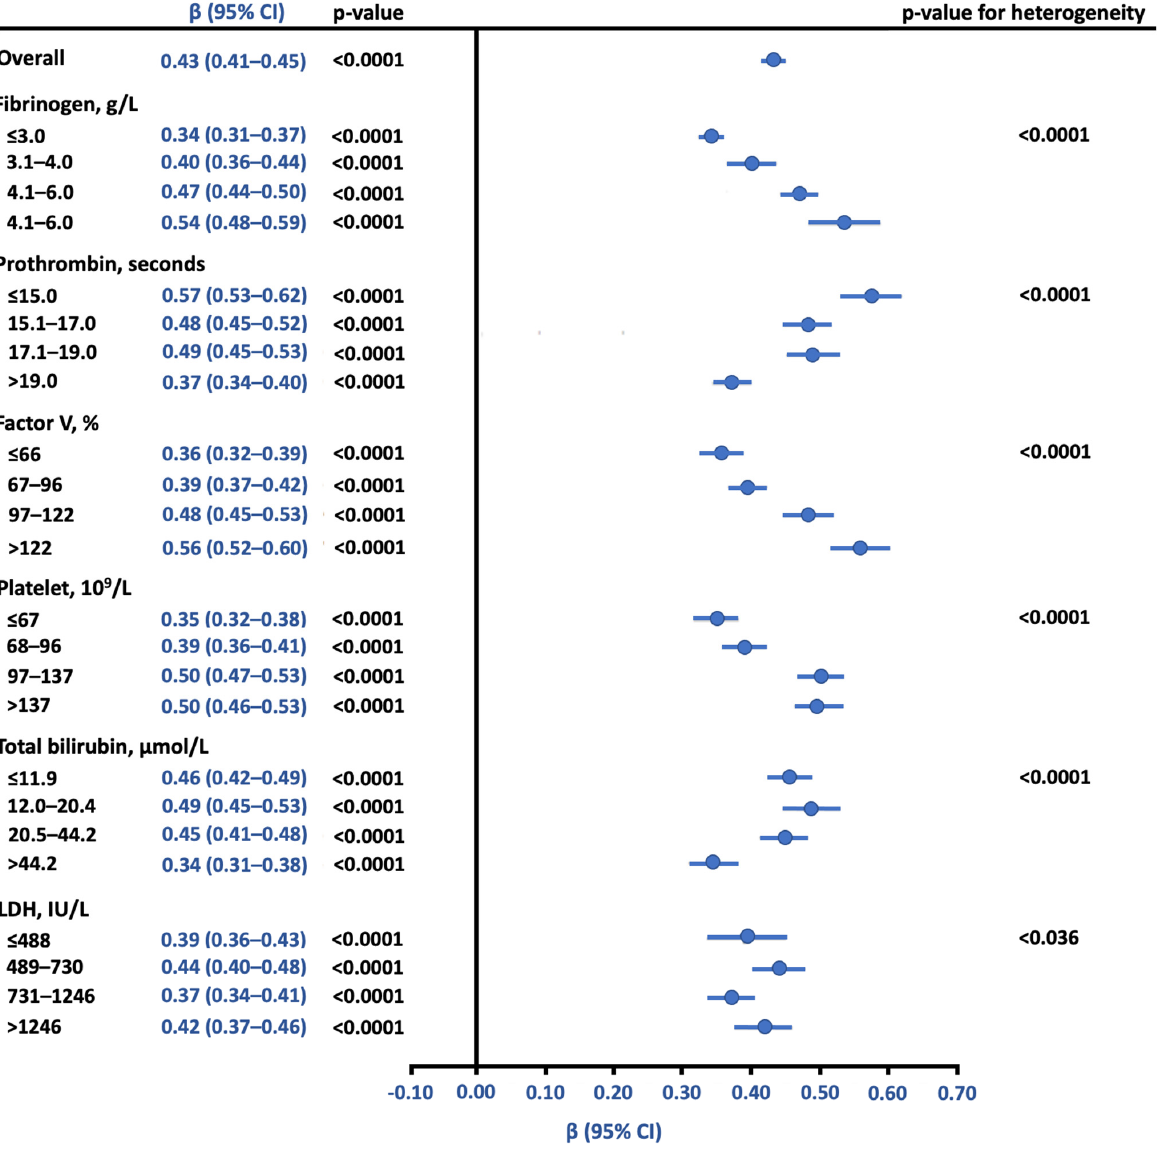
Figure 3. Association of anti-FXa and aPTT, overall and after modulation by biological covariates. β indicates regression coefficient of aPTT on anti-FXa (expressed as 10 − 2 IU/mL) calculated using all available biological measures at the same time points by using linear mixed model (unstructured covariance pattern model to account repeated measurements). Subgroups analyses on other biological data (categorised according to quartiles of all available measures) were made by including the corresponding interaction term into linear mixed models. Prothrombin time (PT), factor V and fibrinogen were analysed on the same citrated samples as aPTT and Anti-FXa. Platelets, bilirubin and lactate dehydrogenase samples were drawn at the same time point as aPTT and Anti-FXa.